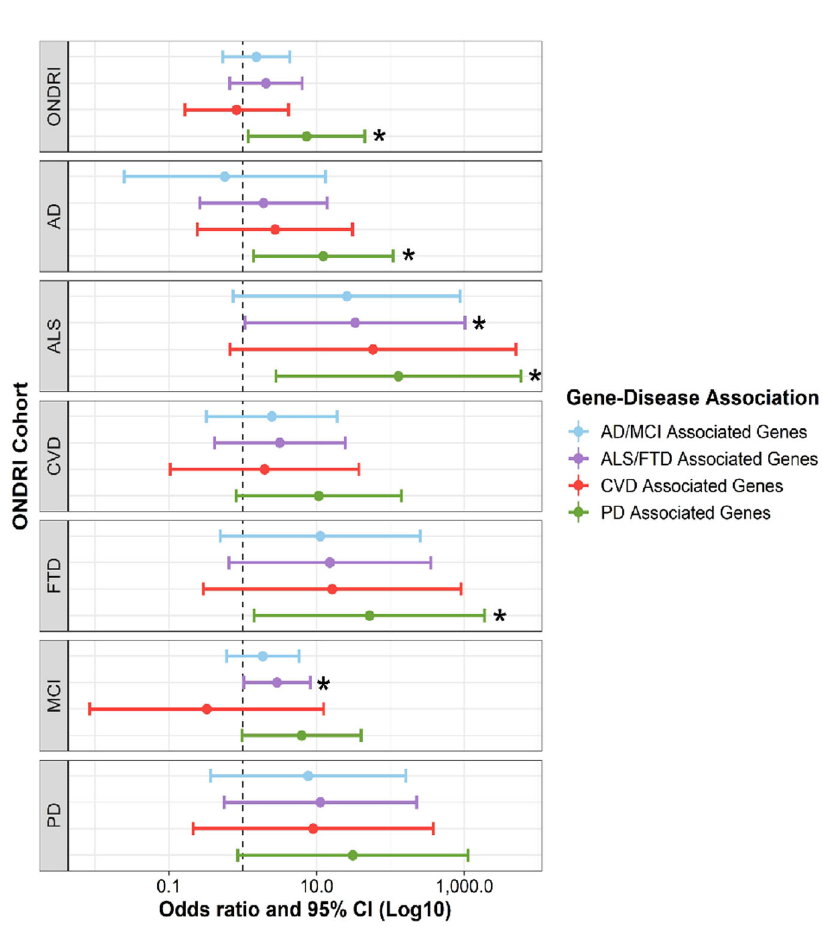
Fig. 1 Rare variant association analysis to analyse enrichment of putative loss of function rare variants in disease-associated gene groupings. Multinomial logistic regressions adjusted for age, sex, and disease prevalence were performed to analyse enrichment of putative loss of function variants (including stop-gain, stop-loss, frameshift, splice acceptor, and splice donor sequence ontologies) identi fi ed in the 80 genes encompassed by the ONDRISeq panel, which were binned into four disease-associated gene groupings across the ONDRI cohorts compared to the control cohort. Only ancestry-matched participants were included in the analyses. The brglm2 R package was used to fi t the regression model and apply a mean bias reduction accounting for the low variant-positive counts. * p < 0.05. Abbreviations: AD Alzheimer ’